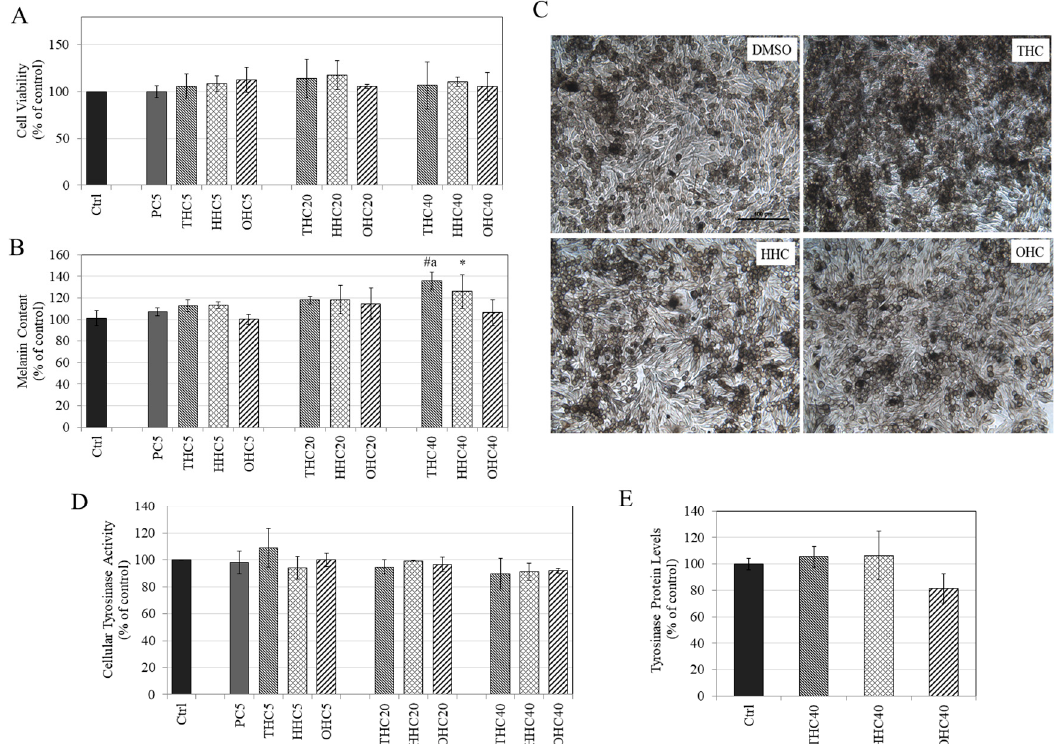
Figure 4. ( A ) Viability of MNT-1 human melanoma cells treated with compounds for 5 d over a concentration range (5–40 µ M) measured by Alamar Blue assay; ( p > 0.05; One-way ANOVA with Tukey’s test; data are mean ± SD of at